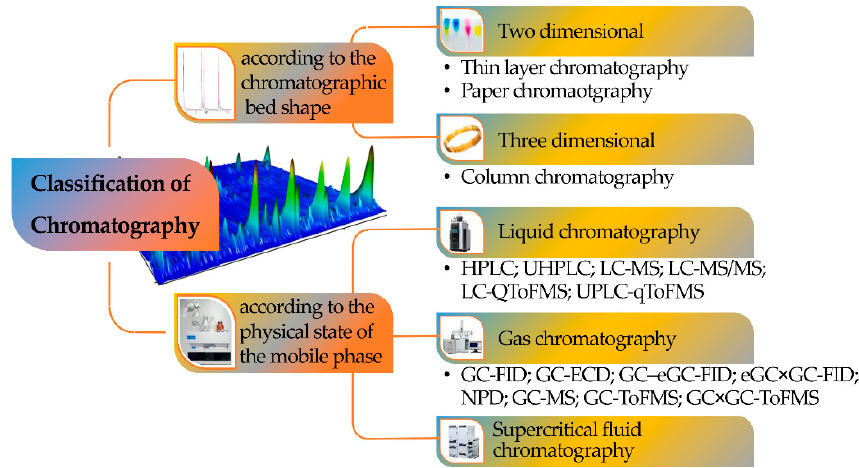
Figure 2. Classification of chromatography according to the chromatographic bed shape and the physical state of the mobile phase.